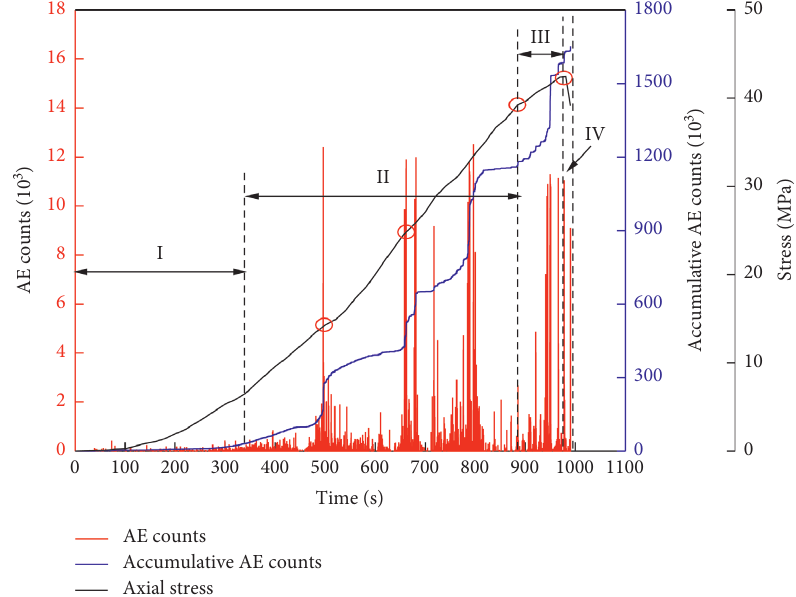
Figure 11: AE counts and accumulative AE counts of the jointed specimens with α � 45 ° .